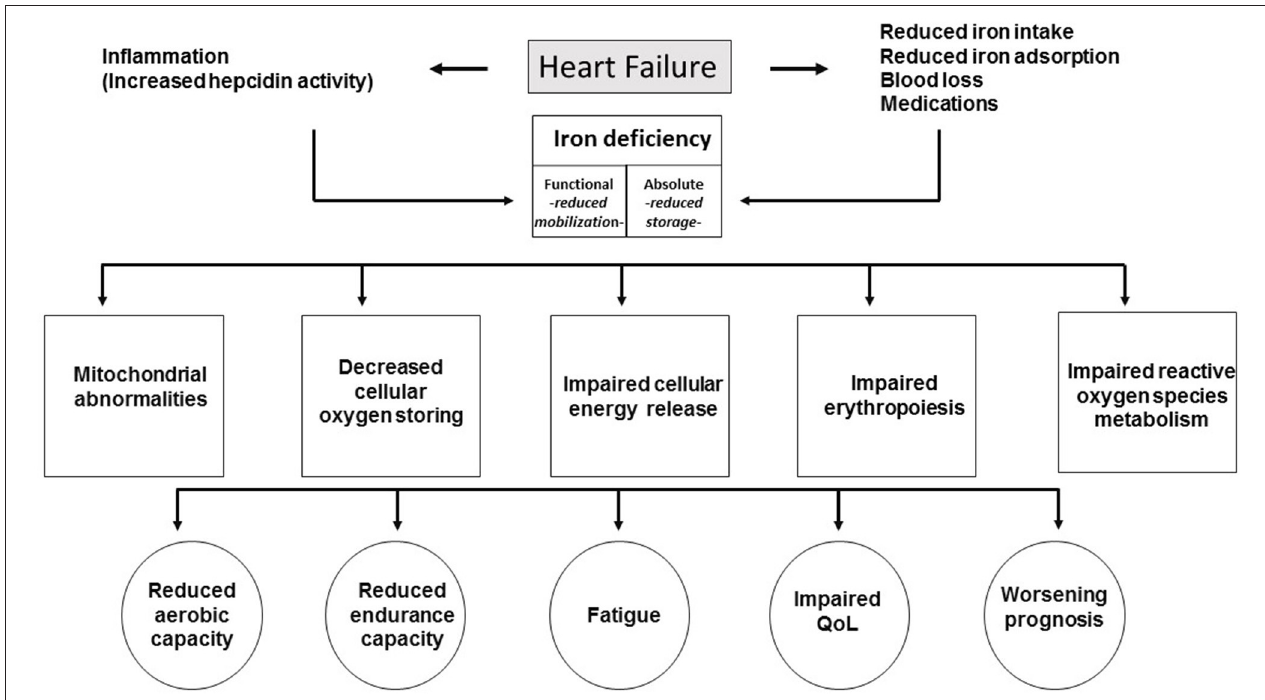
FIGURE 1 | Causes and consequences of ID in